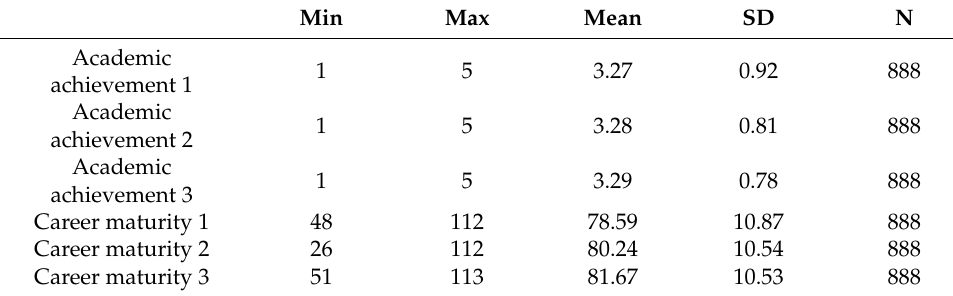
Table 2. Mean and standard deviation of variables.